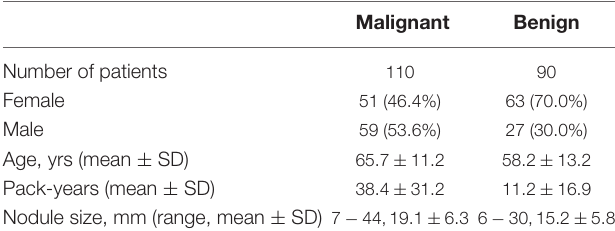
TABLE 1 | Demographics of patient